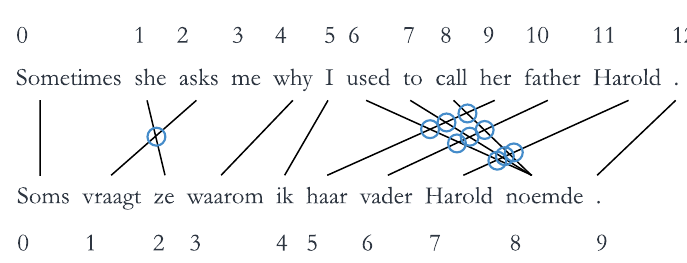
Figure 2. Example of word_cross, with a word_cross value of 10/12 = 0.833... (example taken from Vanroy et al. [21]). (Literal translation of Dutch sentence: * Sometimes asks she why I her father Harold used to call.)